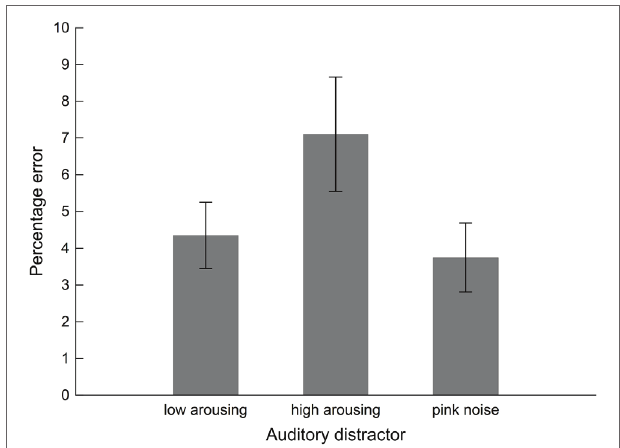
FIGURE 3 | Performance of the students sample ( n = 20) in the intermodal distraction task. Mean values of error percentages during math calculations are shown as a function of distractor sound. Vertical bars indicate standard errors of mean. The presence of high-arousing sound distractors impaired calculation performance (i.e., higher error percentage) compared to both low-arousing and pink noise exemplars.